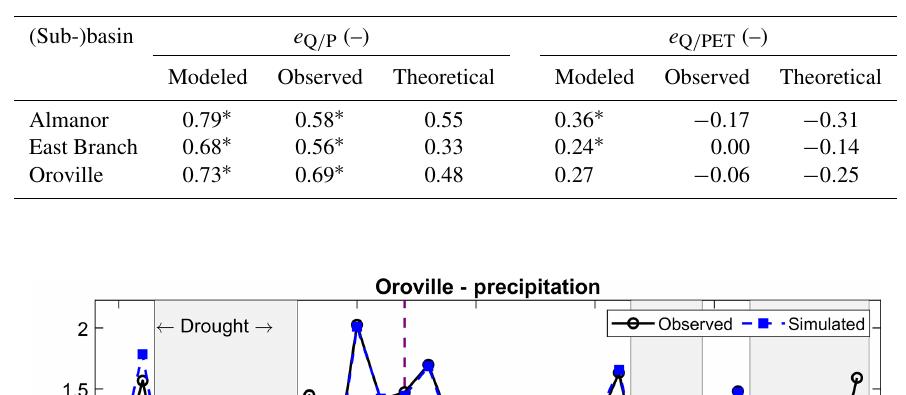
Table 3. Modeled, observed, and theoretical climate elasticity of streamflow to annual precipitation ( e Q / P ) and potential evapotranspi- ration ( e Q / PET ) for the three (sub-)basins under study with complete annual full-natural flow data. Theoretical elasticity was computed according to the Turc–Mezentsev formula (Andréassian et al., 2016). The asterisk ( ∗ ) denotes statistically significant elasticity values (that is, the sign of the confidence bounds agrees, 95% confidence level).